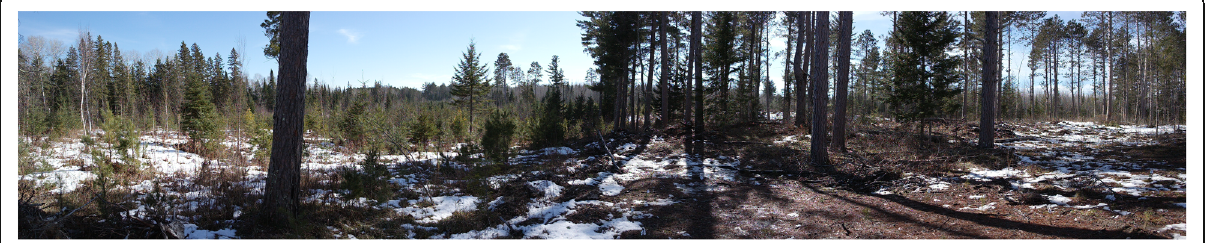
Fig. 8 VRH in a red pine-dominated ecosystem on the Chippewa National Forest, USA, including dispersed trees (left foreground) and small aggregate (center background). (Circa